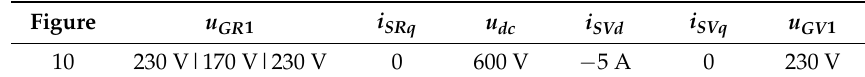
Figure 9. First harmonic of the u GV line to line voltage simulation result. CH1: u SV 12 , 500 V/div; CH2: u dc , 500 V/div; CH3: u SV 12 - 1 h , 500 V/div; CH4: u GV 1 , 200 V/div; CH5: i SV 1 , 10 A/div; 10 ms/div.